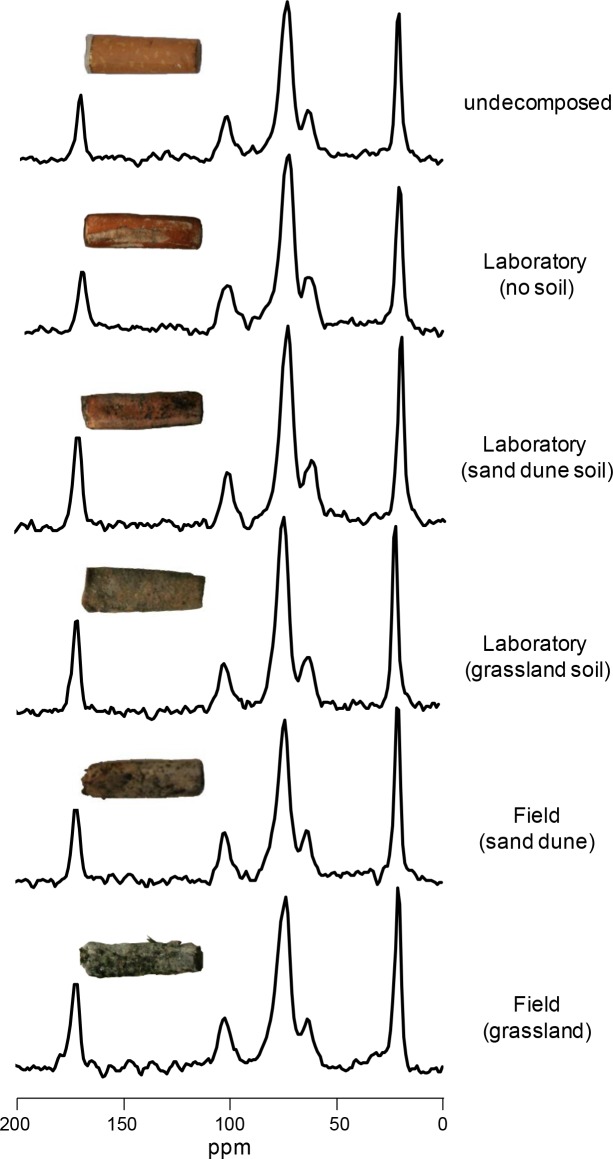
Variation in carbon biochemical quality assessed by 13C CPMAS NMR.Spectra refer to cigarette butts either undecomposed or after 720 days of decomposition in laboratory and field conditions. Insets in each spectra shows pictures of a cigarette butt at the corresponding decomposition stage.